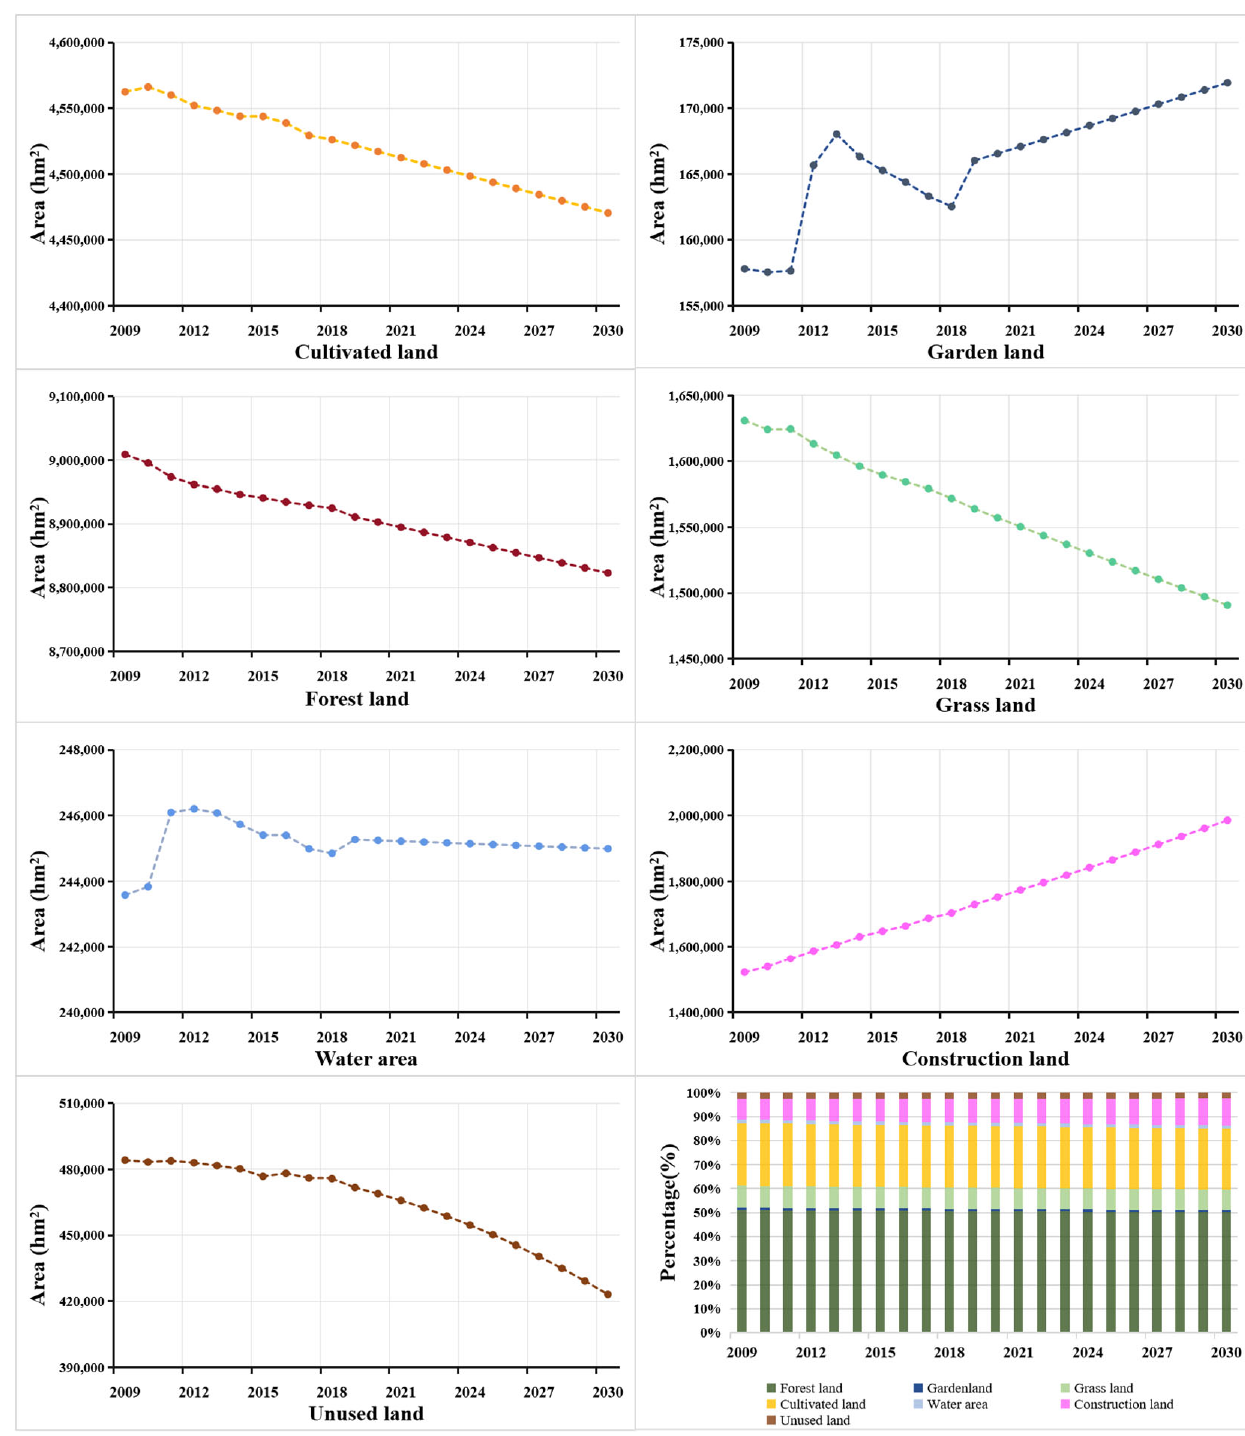
Figure 2. Land use area change of Guizhou Province from 2009 to 2030. The main driving factors for the decrease of cultivated land and the increase of garden land are the implementation of the Grain for Green Program [17,45,46] and the adjustment of the agricultural industry structure, which has turned part of the cultivated land into orchards, tea gardens, and other land use types. The decrease in forest land, grass land and unused land, and the increase in construction land is predominantly due to the de- velopment of social economy [10]. Additionally, Guizhou Province has implemented a large number of resettlements, infrastructure, poverty alleviation industries, and